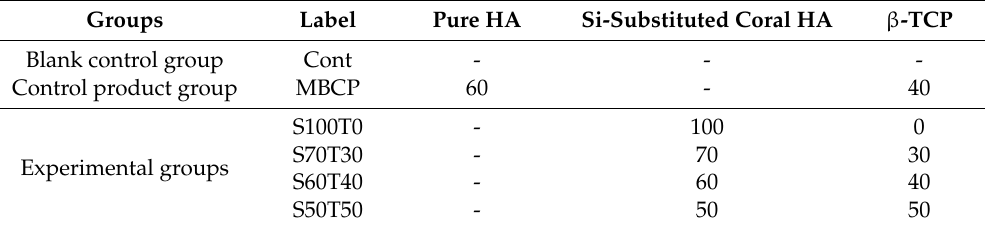
Table 1. Experimental groups used in this